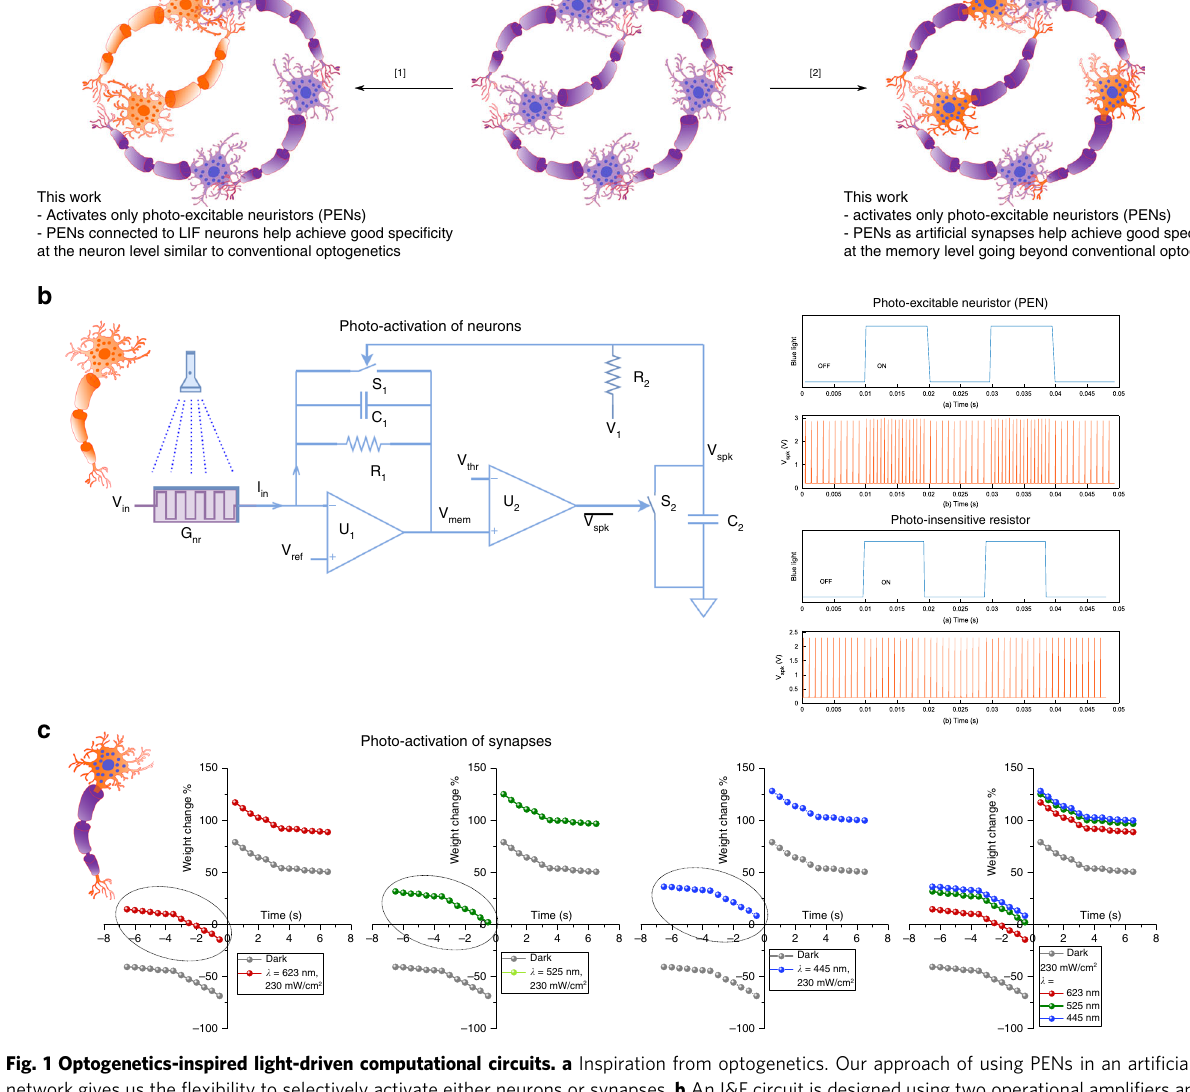
Fig. 1 Optogenetics-inspired light-driven computational circuits. a Inspiration from optogenetics. Our approach of using PENs in an arti fi cial neural network gives us the fl exibility to selectively activate either neurons or synapses. b An I&F circuit is designed using two operational ampli fi ers and the PEN functionally mimicking optically active ion-channels in optogenetics. Without light activation, the neuron fi res at a baseline rate set by the reversal potential V fi cial ion-channel. On illumination by blue light ( λ = 445 nm, amplitude = 5 mWcm − 2 and pulse width = 10 ms), the conductance of the PEN in of the arti (G nr ) increases, resulting in a higher frequency of neuronal fi ring (top). An I&F neuron constructed using conventional resistors does not show any change in fi ring rate on optical stimulation (bottom). c Photo-modulated spike-timing-dependent plasticity learning rules in PENs. The graphs (read row-wise) depict the modulations of STDP upon illumination with red (623 nm), green (525 nm) and blue (445 nm) light with an intensity = 230 mWcm − 2